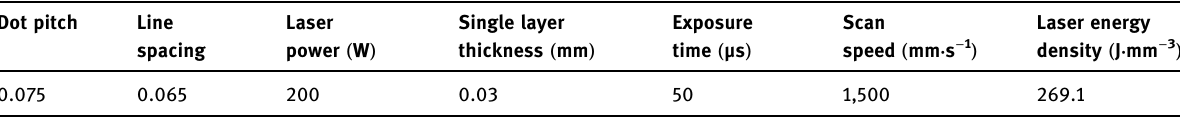
Table 4: Processing parameters of Renishaw AM250 metal 3D printer Dot pitch